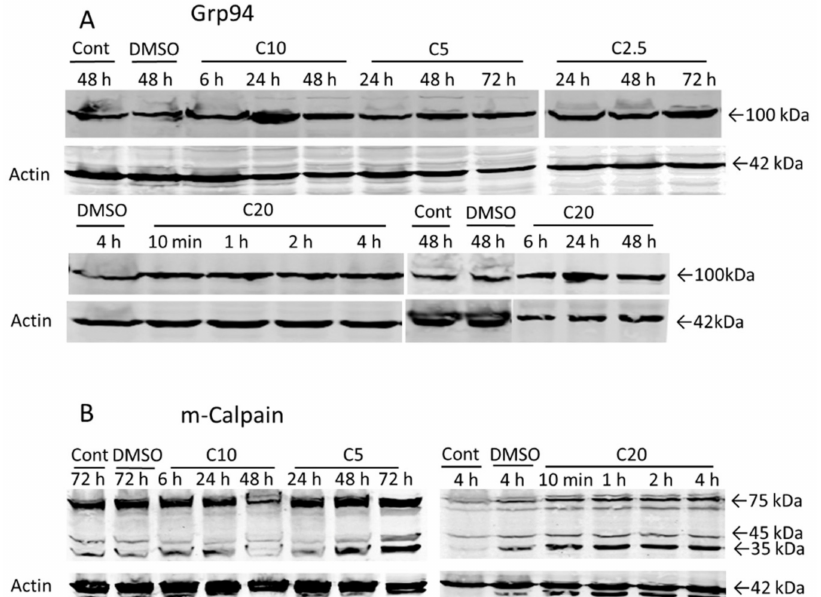
Figure 6. The role of ER damage in COL-3-induced cell death. Cells were treated with COL-3 (C, 2.5–20 µ g/mL) for 72 h and processed for Western blotting. Controls included DMSO (D)-treated (vehicle control) and untreated cells. Protein expression of Grp94 ( A ) and activation of m-calpain ( B